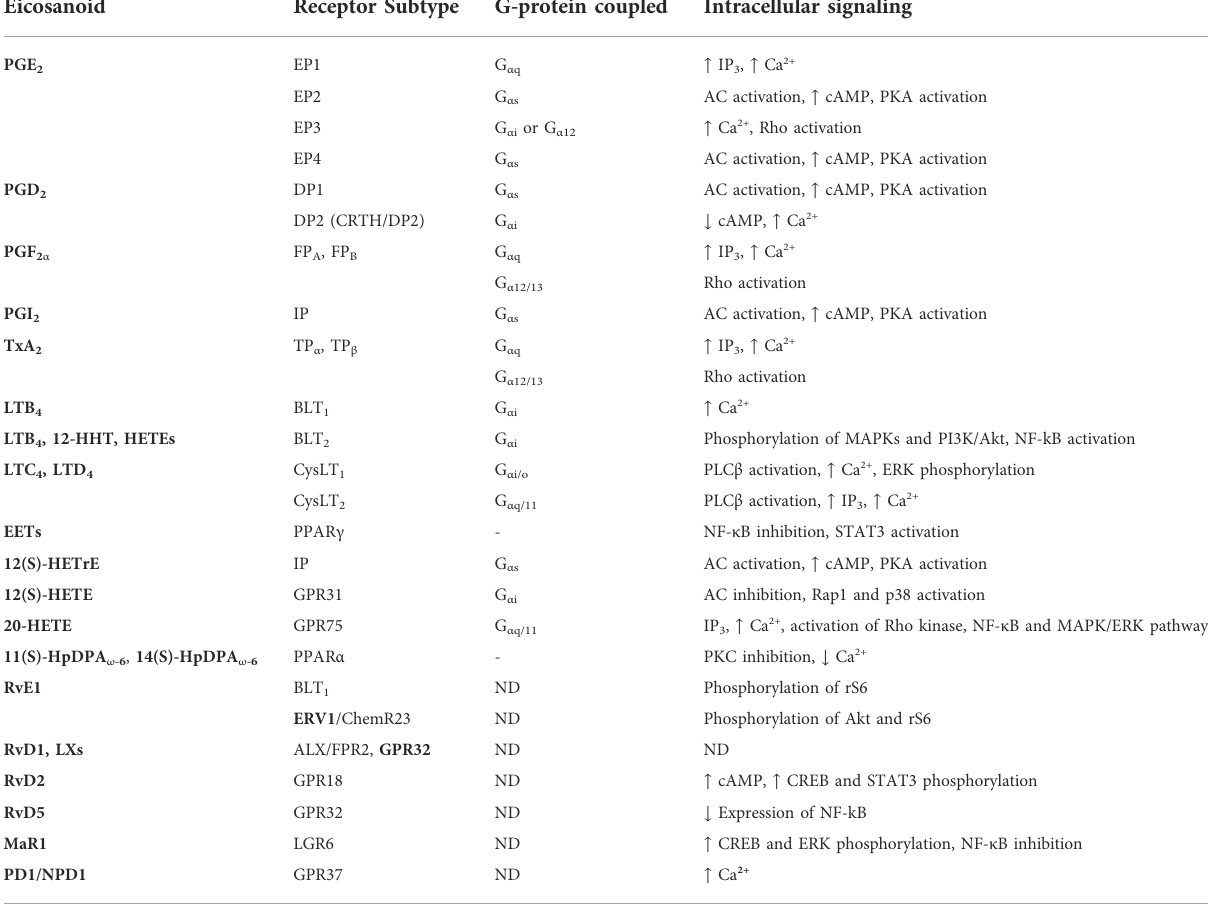
TABLE 1 The signal transduction of the eicosanoid receptors.